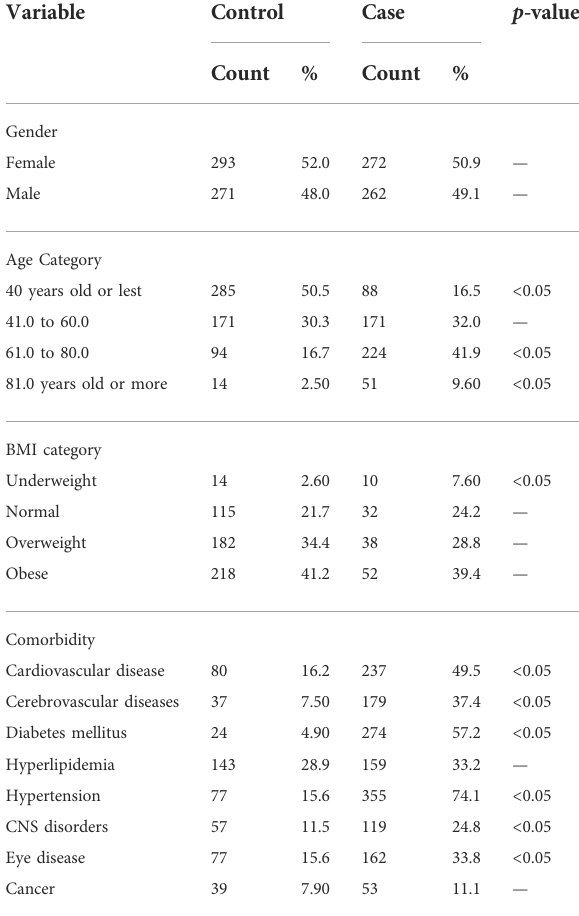
TABLE 2 Categorical baseline characteristics of the participants.